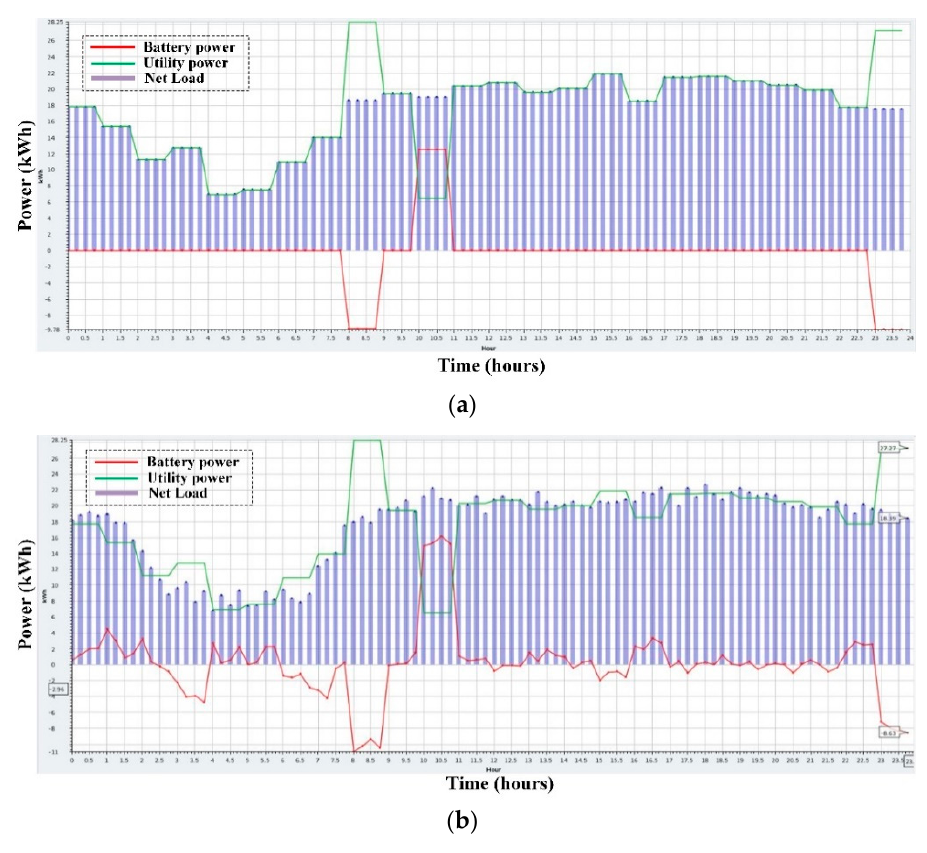
Figure 6. HMI screens showing the scheduled battery power, utility power, and net load of ( a ) day-ahead scheduling; ( b ) hour-ahead scheduling.